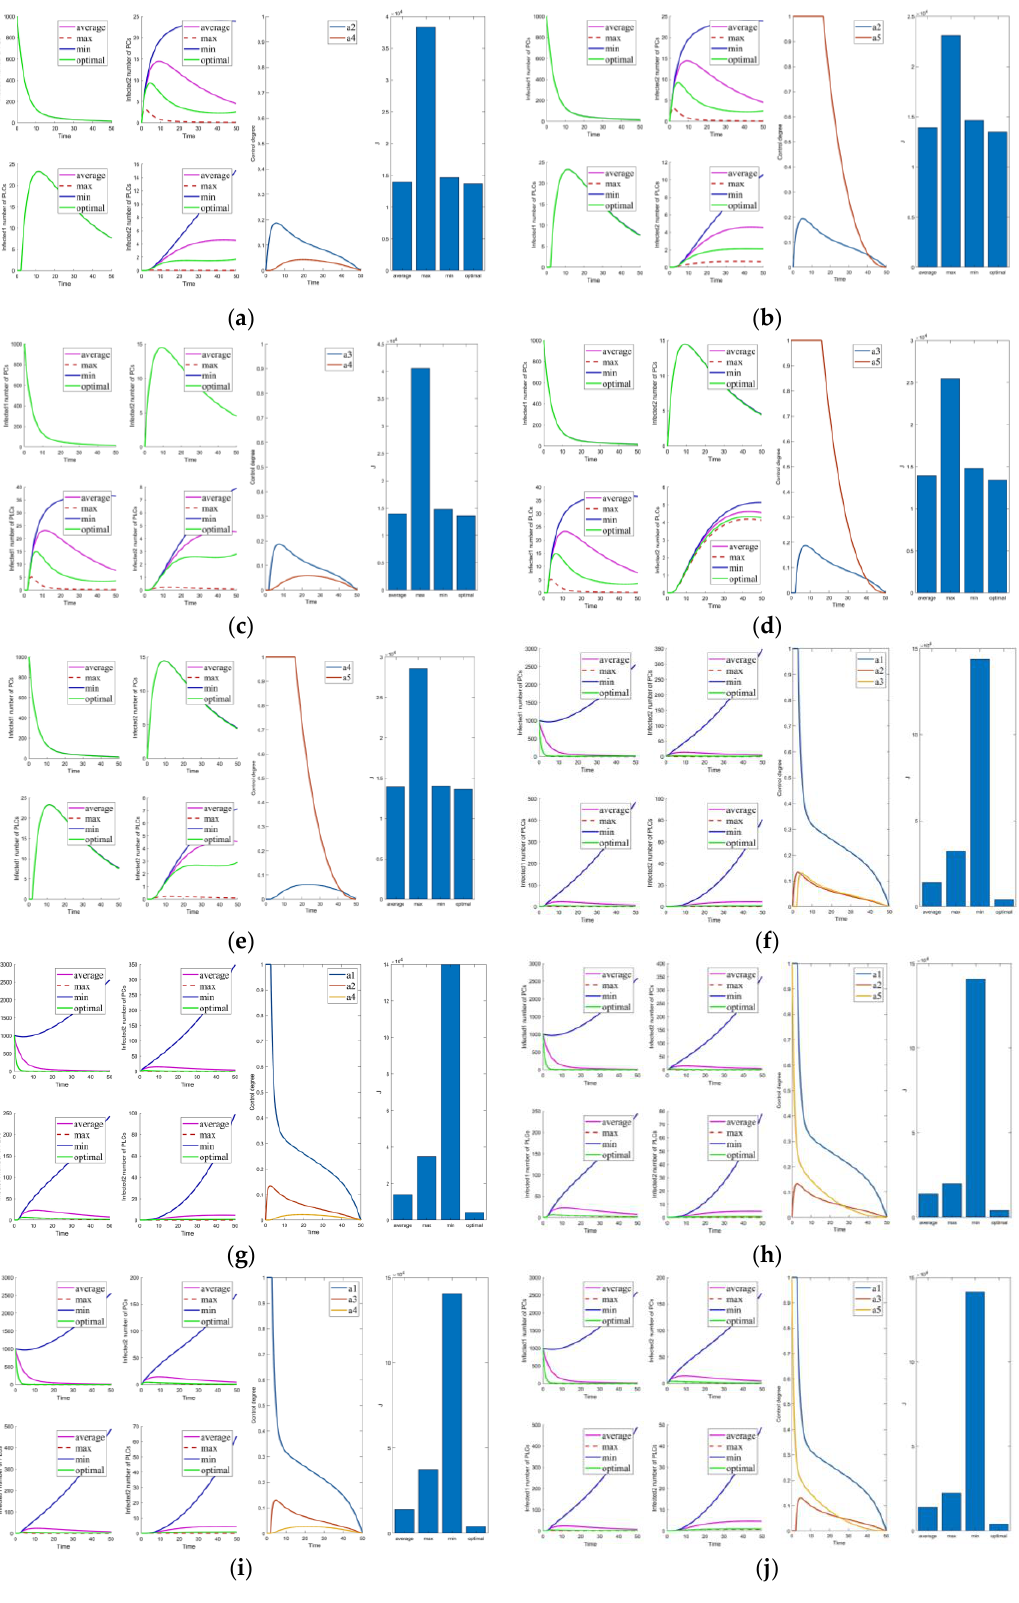
Figure 4. Solutions of the optimal control strategies for Cases 11 – 20. ( a ) Case 11; ( b ) Case 12; ( c ) Case 13; ( d ) Case 14; ( e ) Case 15; ( f ) Case 16; ( g ) Case 17; ( h ) Case 18; ( i ) Case 19; ( j ) Case 20.